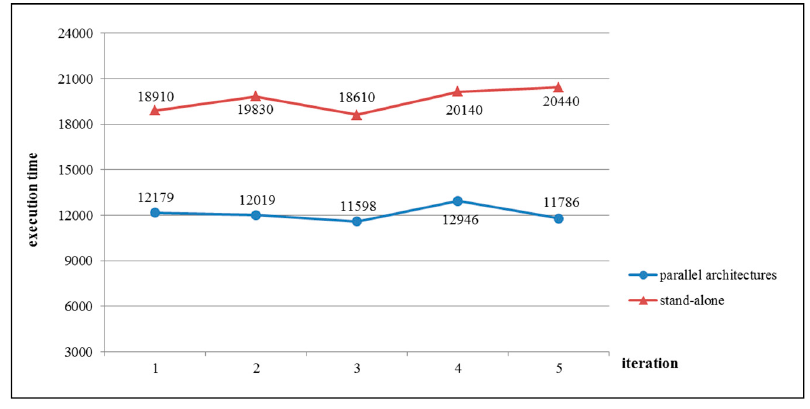
Figure 6. Efficiency test of Experiment 3.